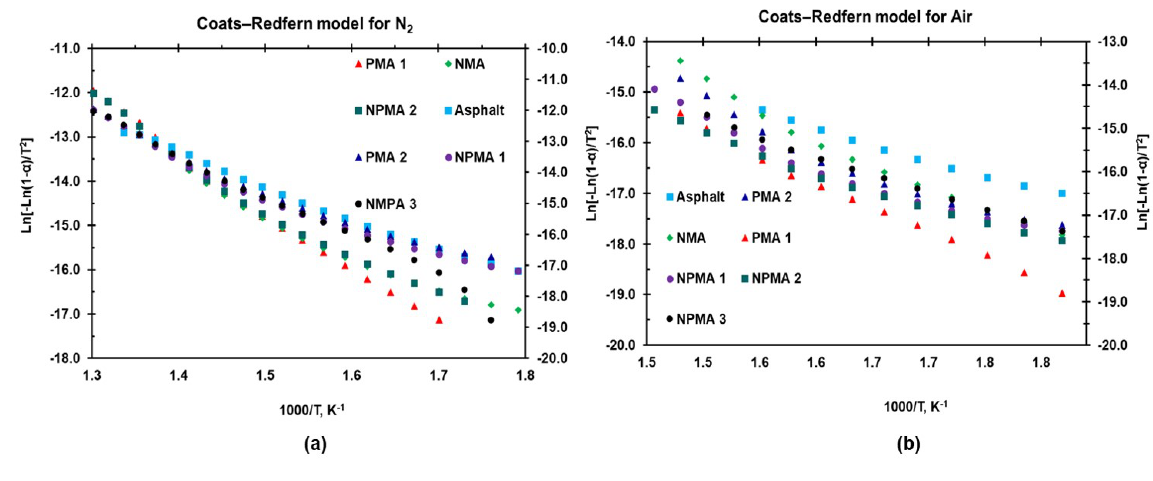
(cid:104) − ln ( 1 − α ) (cid:105) versus 1000 in (a) air; (b) T T 2